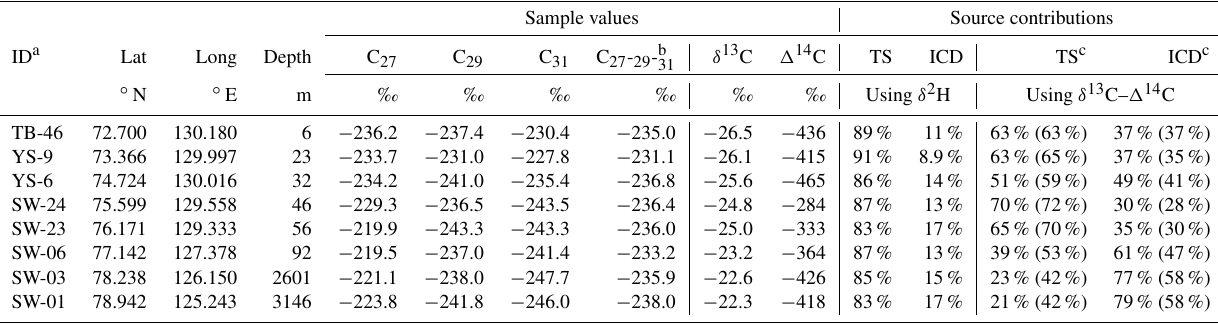
Table 6. Location, sampling depth and isotopic values of samples along a surface sediment transect in the Laptev Sea (data from Bröder et al., 2016b), with percentage topsoil (TS) and ice complex deposit (ICD) OC contributions to the samples based on source-apportionment